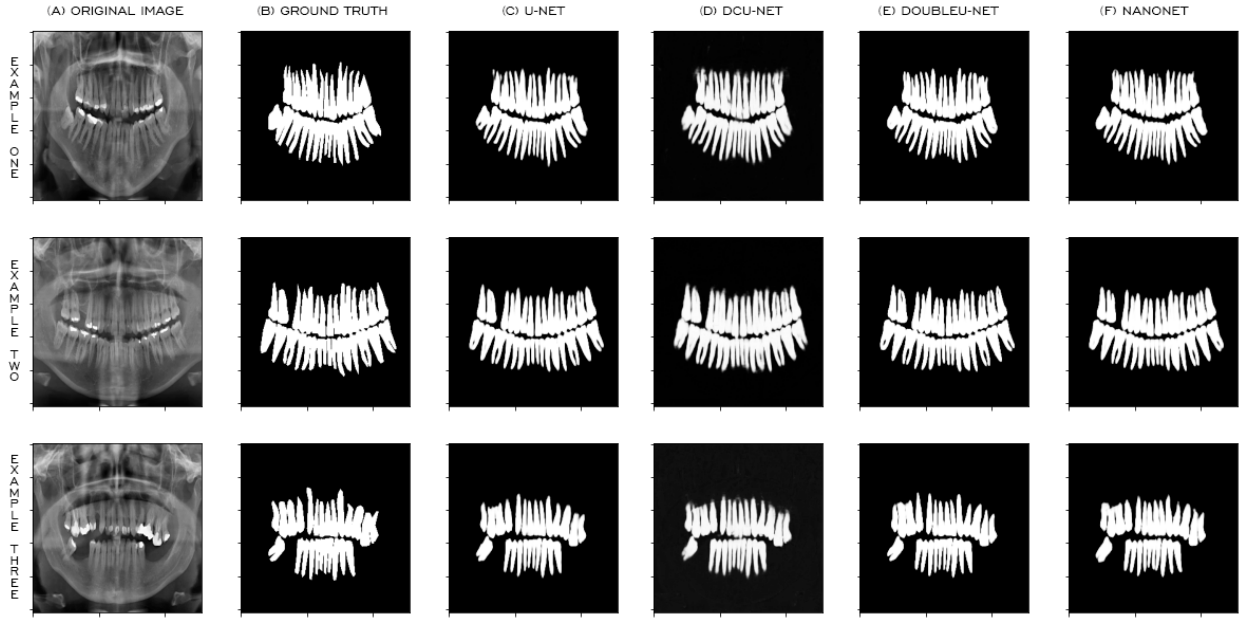
Figure 6. Example of three panoramic radiograph images tested by segmentation models without data